Question: Produce a descriptive caption suitable for publication.
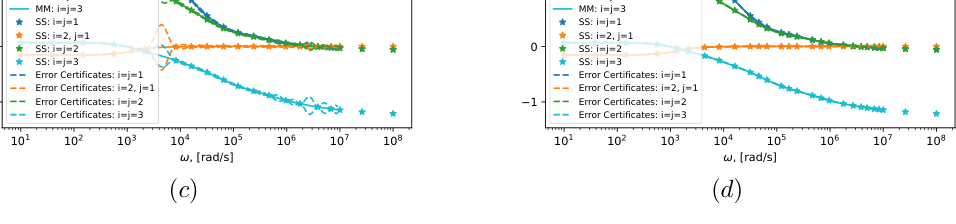
Answer: Conducting magnetic cleaver: Showing p ˜ Rqij and p ˜ R ` ∆qij obtained by applying the adaptive PODP Algorithm 1 at iterations paq k “ 1, pbq k “ 2, pcq k “ 4, and pdq k “ 8.